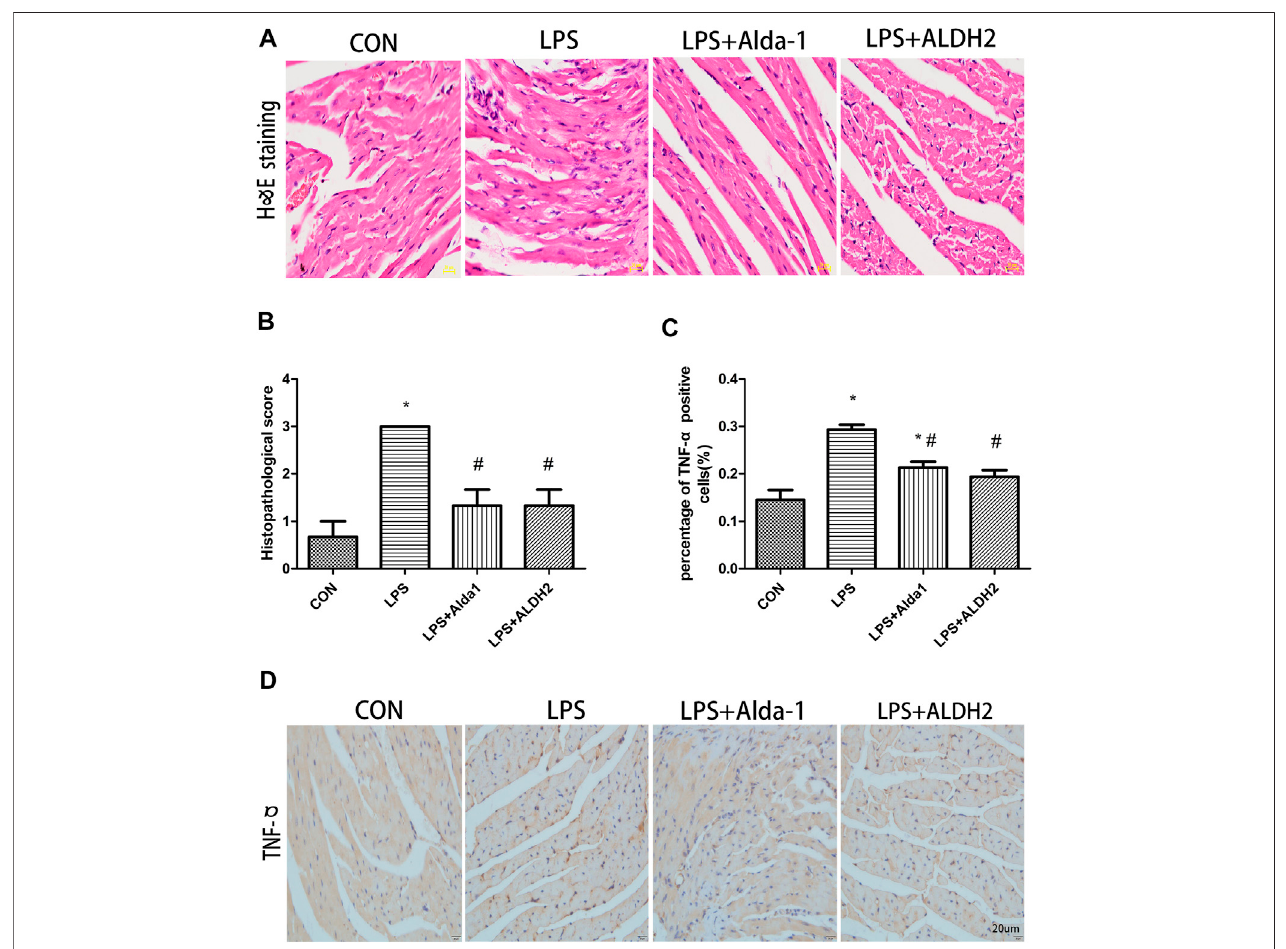
FIGURE 4 | Heart tissue pathology and in fl ammation in lipopolysaccharide (LPS)-treated mice. (A) Hematoxylin and eosin staining of heart tissue. Magni fi cation, × 400. Scale bar: 20 µm. (B) Histopathological scores of heart tissue. (C) Quanti fi cation of tumor necrosis factor (TNF)- α -positive cells detected by immunostaining. (D) TNF α expression was examined by immunohistochemical staining. Scale bar: 20 µm. Data are the mean ± standard error of the mean. n (cid:1) 3 mice/group. Statistical analyses were performed by one-way analysis of variance, followed by Tukey ’ s post hoc test for multiple comparisons. * p < 0.05 vs. control (CON); # p < 0.05 vs.